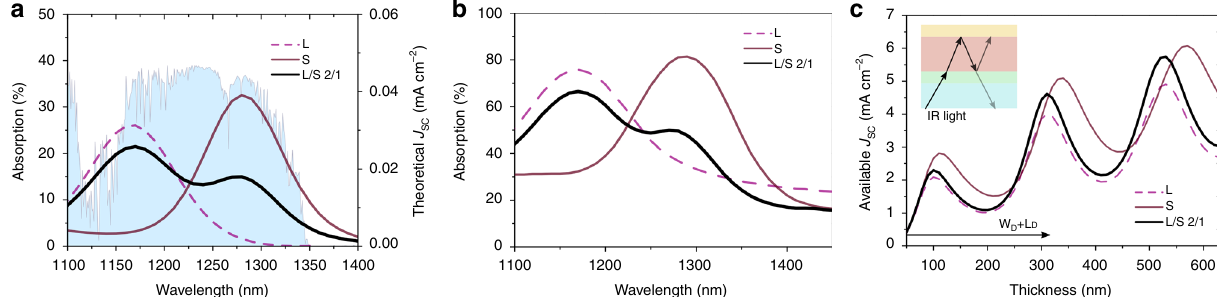
Fig. 3 Expected J SC from multi-bandgap CQD ensembles. absorptance measured from ( a ) the CQD fi lms on glass and b complete solar cell devices including the gold electrode mirror; c calculated J SC as a function of CQD fi lm thickness